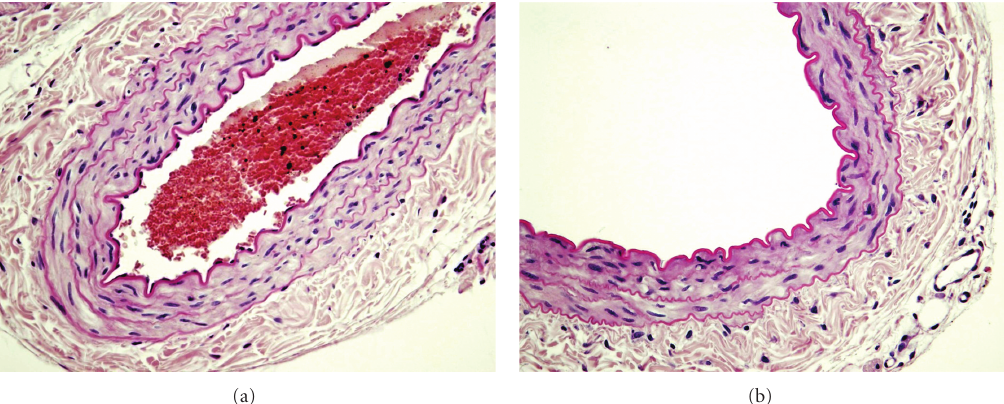
Figure 2: Histological preparations of rat femoral artery with (a), and without (b) endothelial cell layer (hematoxyline and eosin staining, magnification = 400x). Table 1: CPCA-induced relaxation in isolated rat femoral artery in the absence or in the presence of the specific pharmacological intervention. Concentration of CPCA eliciting 50% of its own maximum response ( EC 50 ) is presented as pEC 50 ( pEC whereas maximal obtained relaxation is expressed as a percentage of the precontraction produced by phenylephrine. Each result represents the mean ± SEM ( n = 4 −